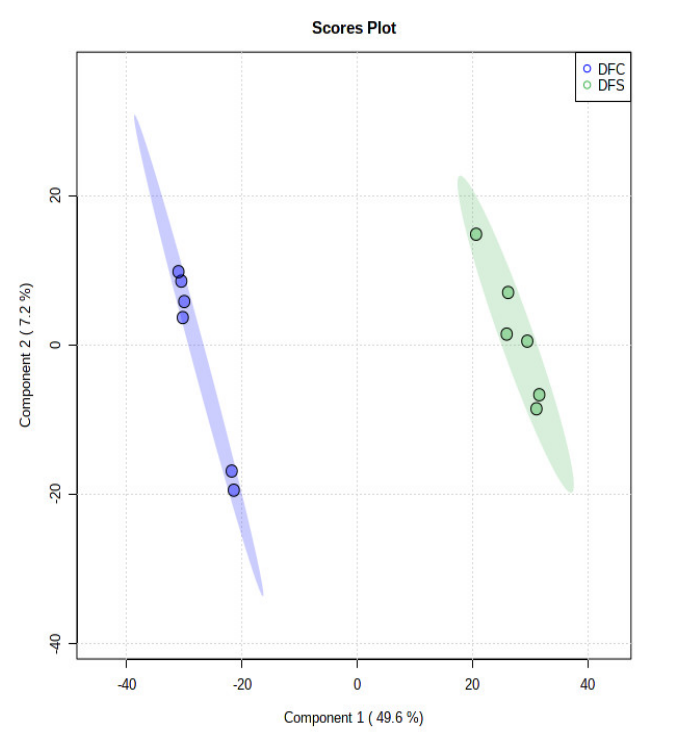
Figure 7. PLS-DA scores plot in supervised analysis. Predictive components 1 versus 2 showing the supervised separation between the two sample groups (DFC and DFS) based upon the culture supplementation.